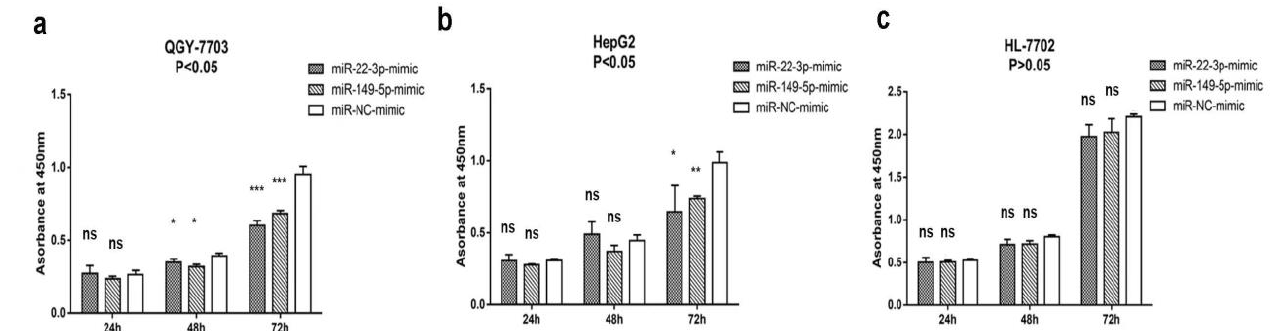
Figure 2. MiR-22-3p and miR-149-5p mimics suppress proliferation in human hepatocellular car- cinoma cells but not in normal human hepatocyte cell. ( a , b ) Effect of miR-22-3p mimic (100 nM), miR-149-5p mimic (100 nM), and controlled miR-NC mimic (100 nM) on QGY-7703 and HepG2 cell proliferation was measured by the CCK8 assay at 24, 48, and 72 h post-transfection; ( c ) effect of miR-22-3p mimic (100 nM), miR-149-5p mimic (100 nM), and controlled miR-NC mimic (100 nM) on HL-7702 cell proliferation was measured by CCK8 assay at 24, 48, and 72 h post-transfection. Absorbance was read at 450 nm. Data are presented as mean ± S.D. ( n = 3; * p < 0.05, ** p < 0.01, *** p < 0.001, ns stands for no significant difference).